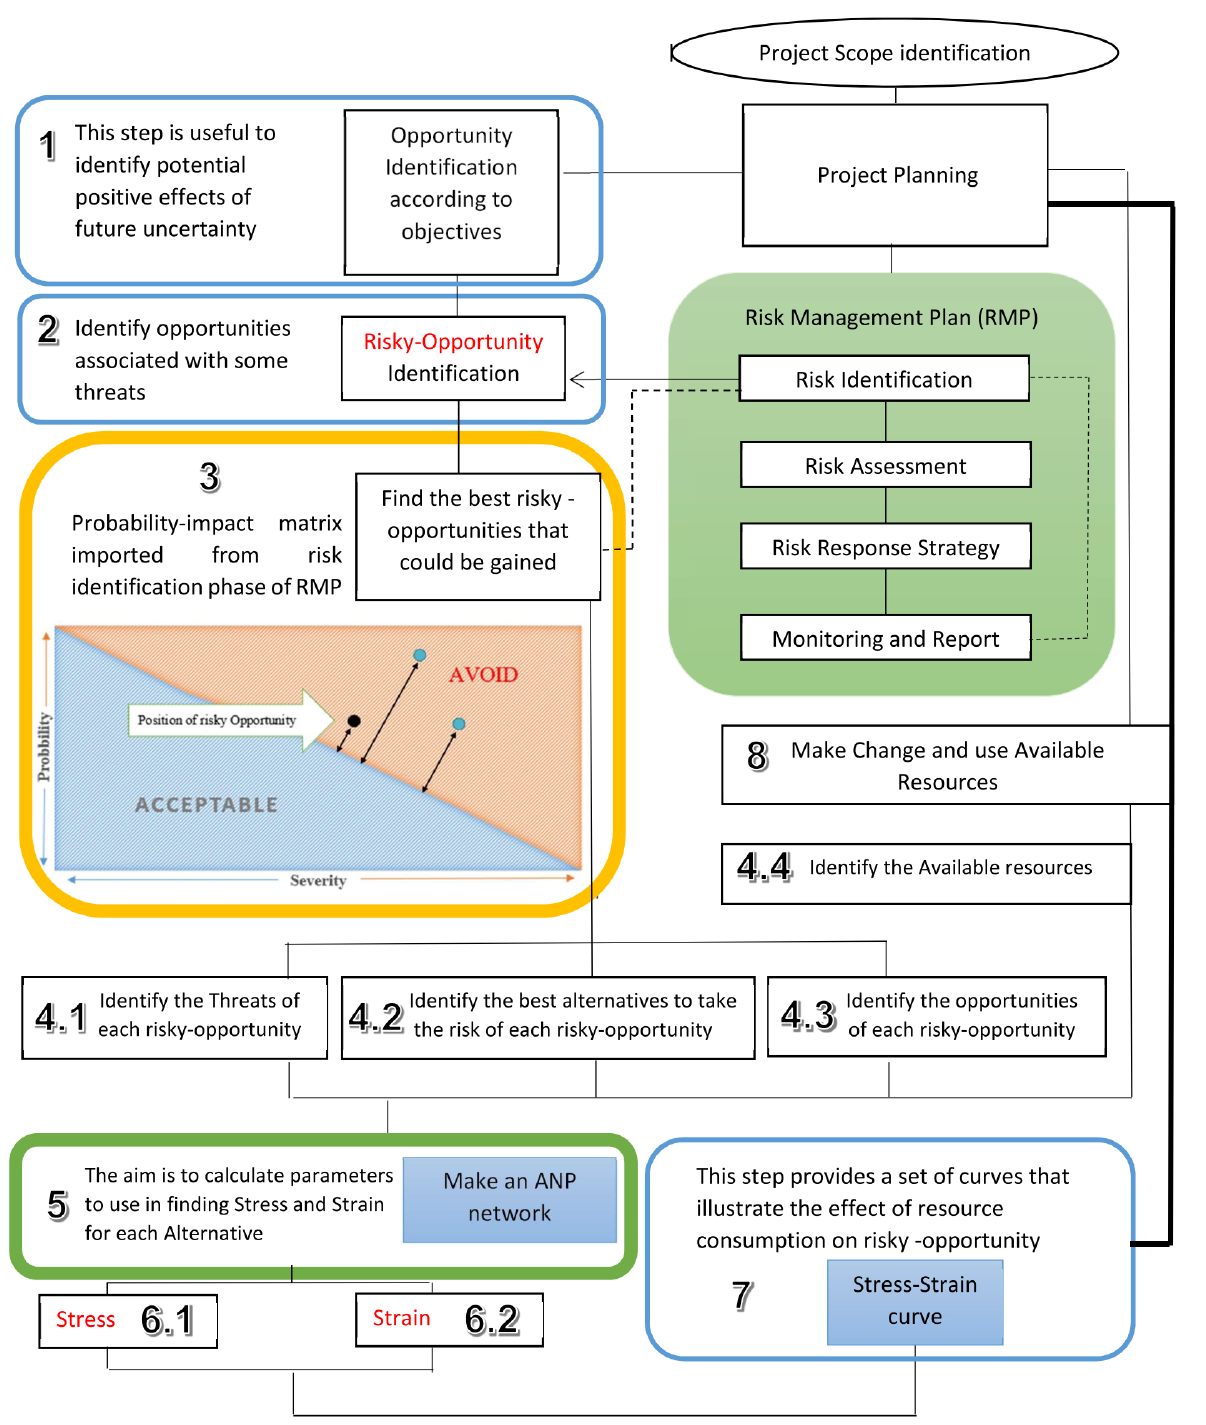
Figure 1. General process of the digitalization risk acceptance evaluation employing ROAM (Aghazadeh Ardebili